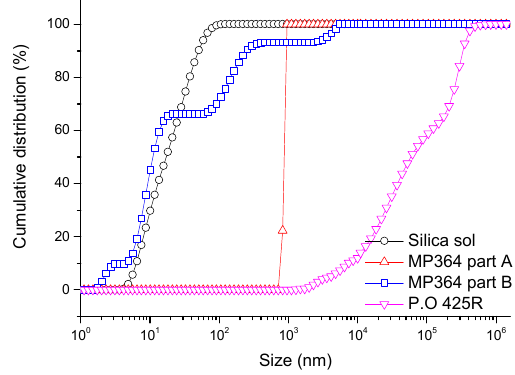
Figure 4. Particle size cumulative distribution of different grouts.